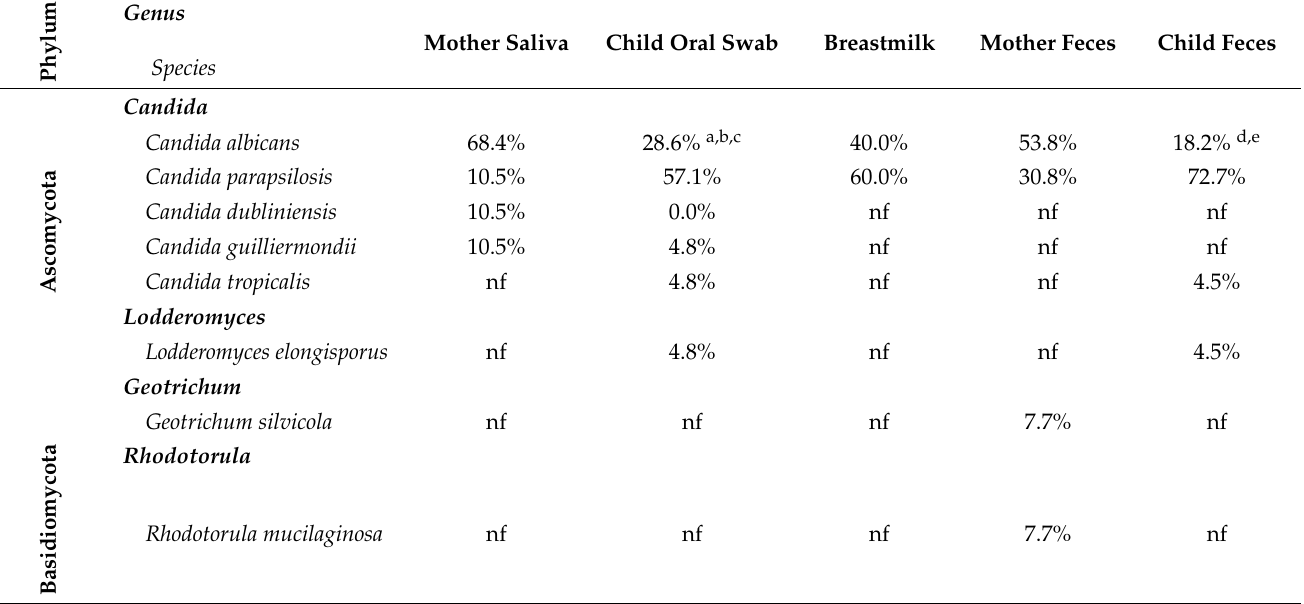
Table 2. Prevalence of each species identified per sample